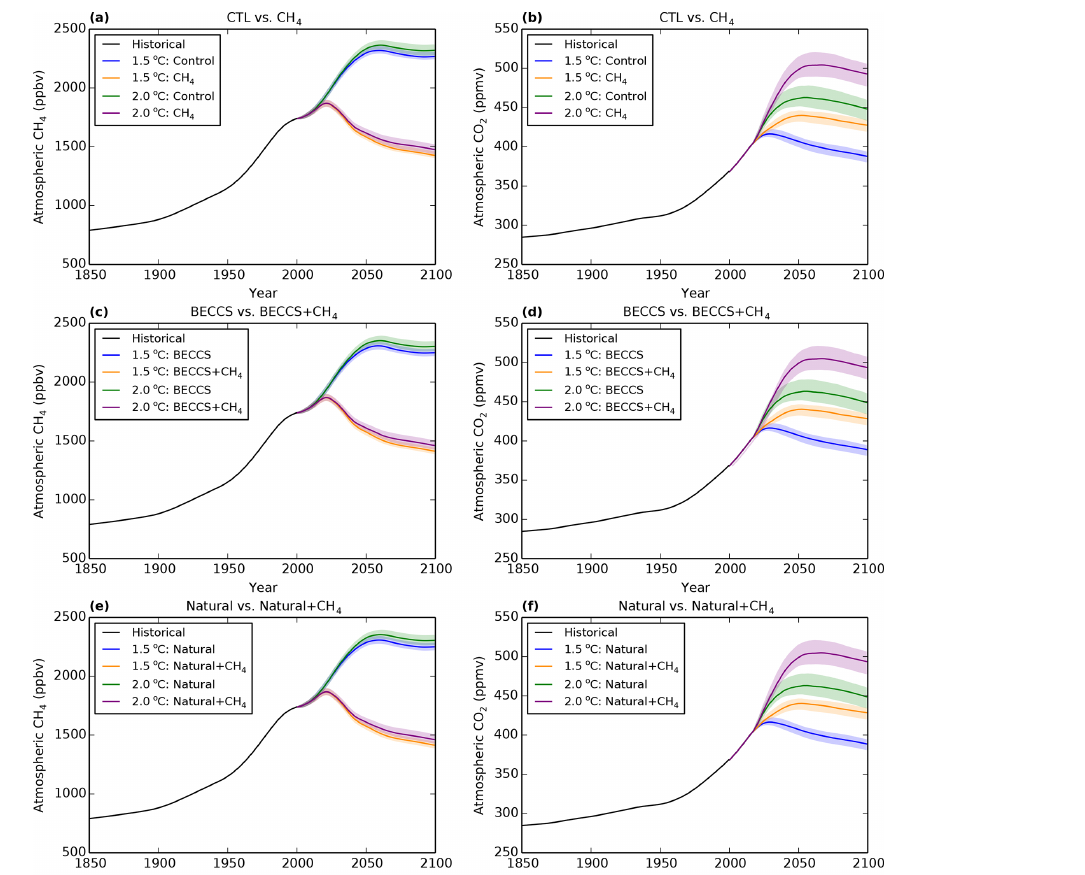
Figure 6. (a, c, e) Time series of the ensemble median atmospheric CH 4 concentrations (with interquartile range as spread) derived for each temperature profile for the following scenarios: (a) CTL and CH 4 , (c) BECCS and BECCS + CH 4 , (e) Natural and Natural + CH 4 . Panels (d, f, h) show the corresponding time series for the atmospheric CO 2